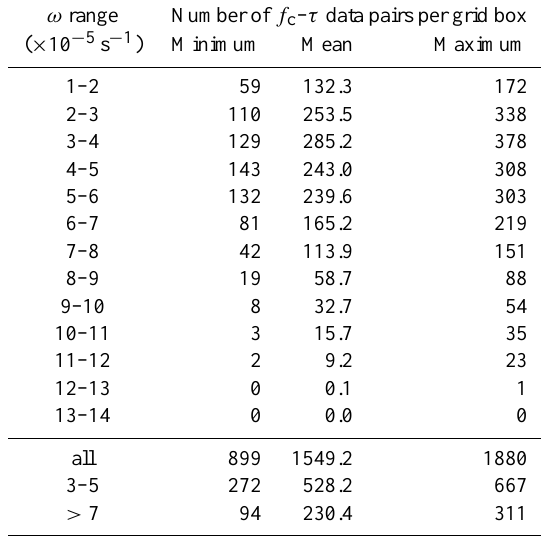
Table 1. Minimum, mean and maximum number of f c – τ data pairs per storm-centric 200km × 200km grid box for different 850hPa relative vorticity ( ω ) ranges over the North Atlantic ocean. ω